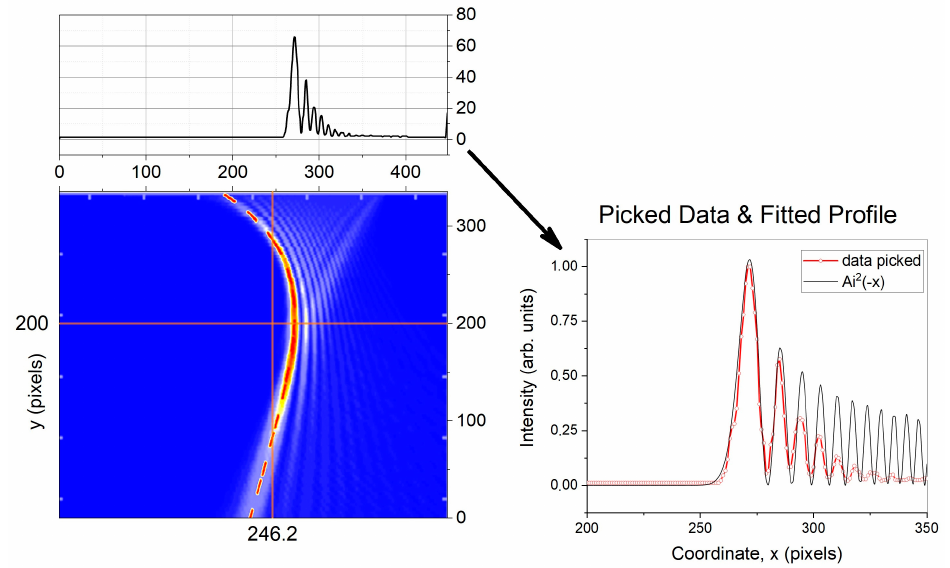
Figure 6. Intensity profile fitting results. Adapted from